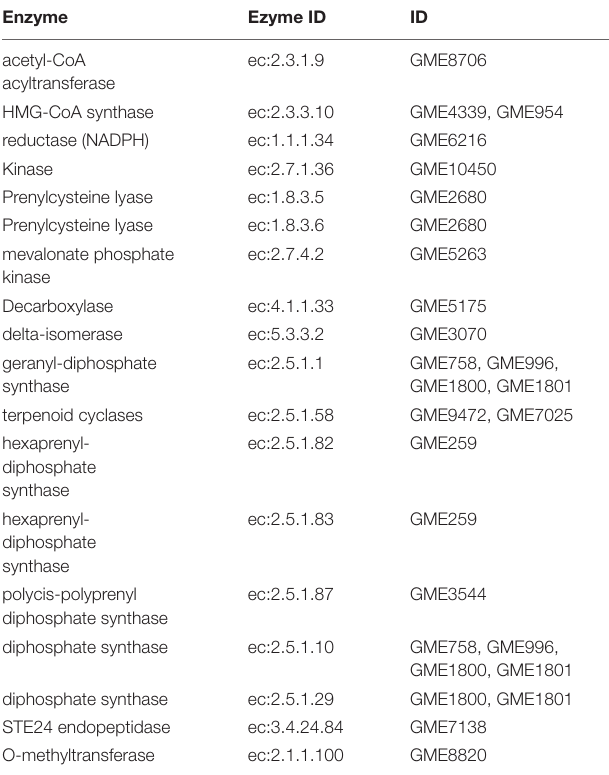
TABLE 2 | Terpenoid backbone biosynthesis (Total =